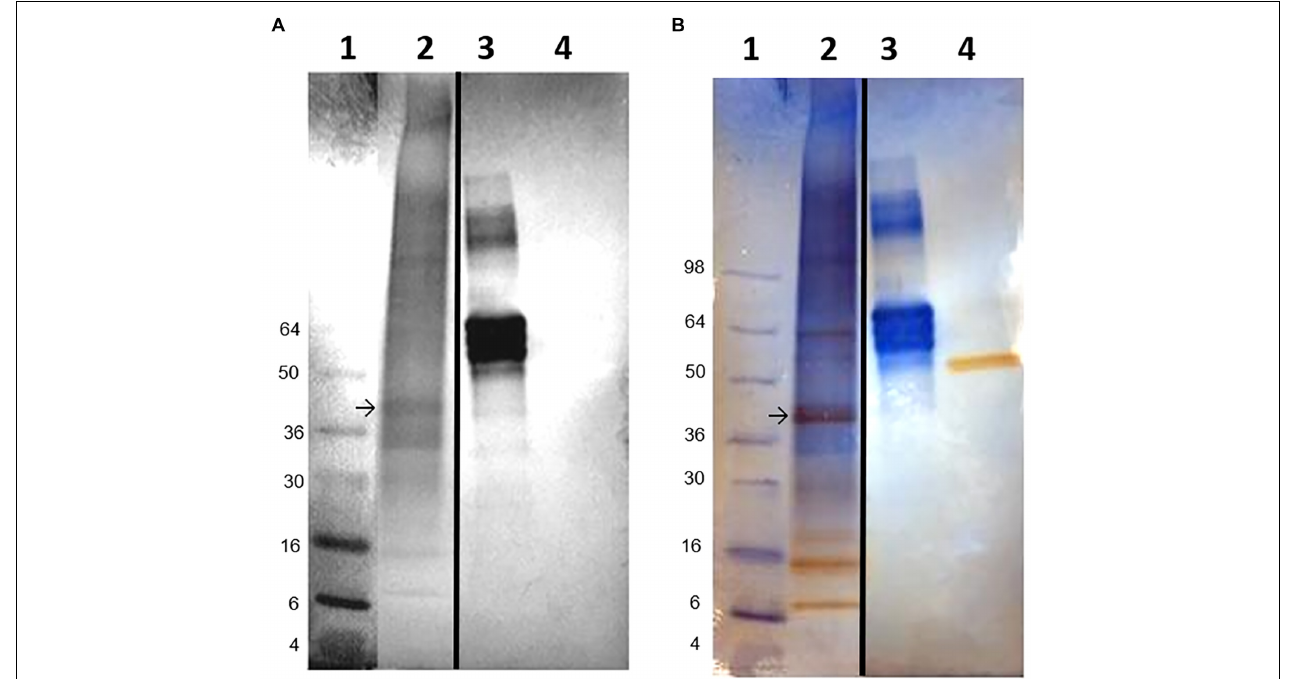
FIGURE 2 | Glycoprotein detection in soluble shell matrix proteins. (A) Twenty-five µ g (dry weight) of each protein was resolved using a 10% Tris-glycine gel and transferred onto nitrocellulose. The blot was stained to identify glycosylated protein. Lane 1- SeeBlue protein molecular weight standards labeled in kDa. Lane 2- SM. Lane 3- Fetuin (glycosylated protein control). Lane 4- Creatinase (non-glycosylated protein control). The intensity of staining is proportional to the amount of carbohydrate present on each protein. SM appears to contain a broad range of lightly glycosylated proteins. The 48 kDa band is indicated with an arrow and shifted to a lower apparent molecular weight following blotting when compared to Figure 1A . This shift was observed commonly following blotting. A band identified at approximately 34 kDa was not identifiable in Figure 1A following Stains-all staining. Stained gels were photographed in black and white to enhance detectability of faint blue bands. (B) The same blot as in (A) was re-stained for protein to distinguish non-glycosylated proteins from glycosylated proteins. In lane 3, fetuin remains blue and is indicative of its heavy glycosylation. Creatinase is now apparent in lane 4. In lane 1, the 48 kDa band shifts toward brown staining indicating less glycosylation than the 34 kDa band which remains blue. For this analysis, only lanes showing data pertinent to this study are presented. Lanes 1 and 2 were cropped from the original blot and digitally placed next to lanes 3 and 4 (controls) which were also cropped from the original image; the splice sites are demarcated by a black line. In (A) , the contrast in Lane 1 was digitally adjusted to visually discern the protein standards.